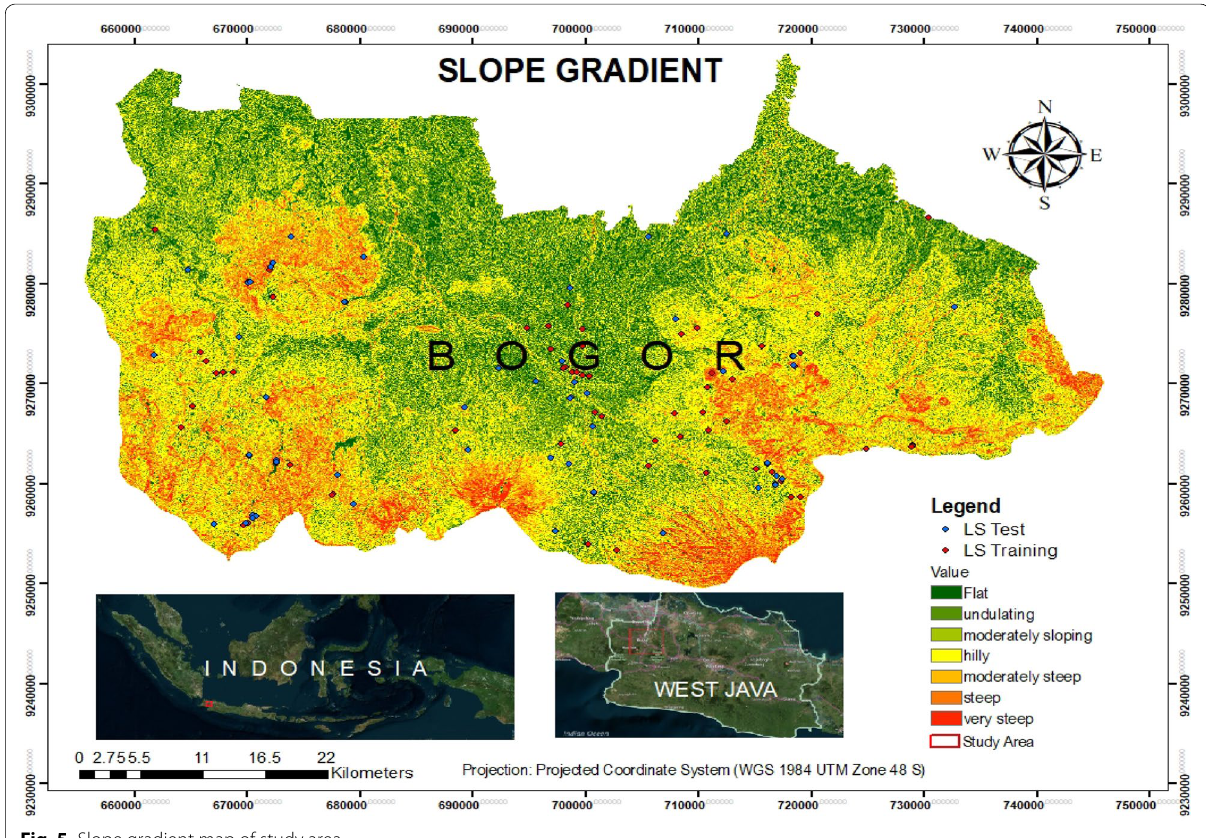
Fig. 5 Slope gradient map of study